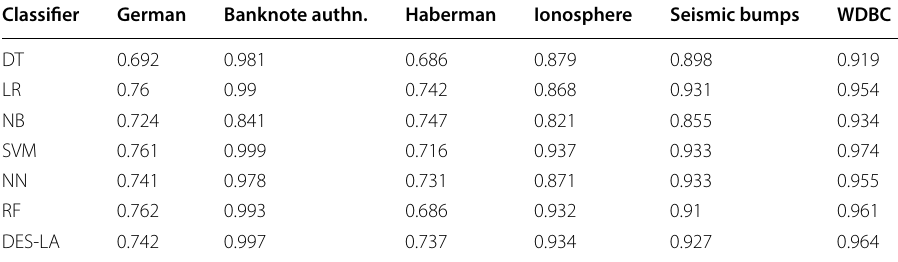
Table 2 Classifier accuracy without filtering